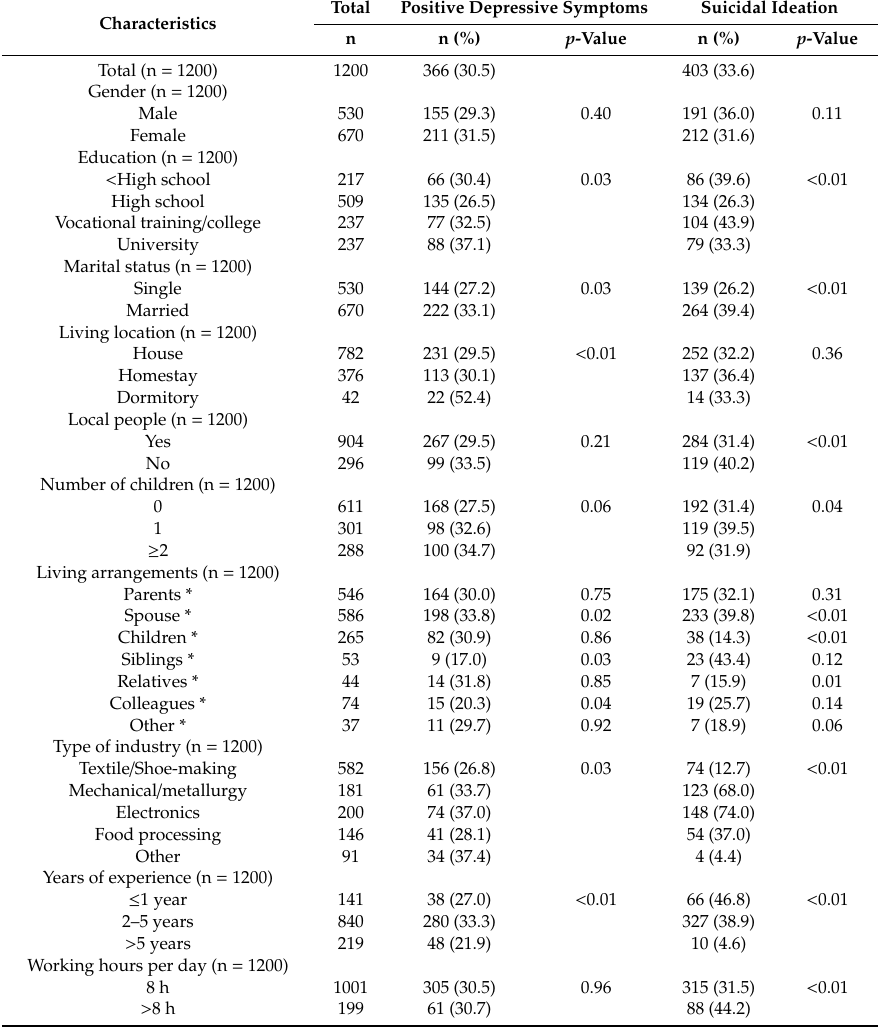
Table 1. Depressive symptoms by socioeconomic and working